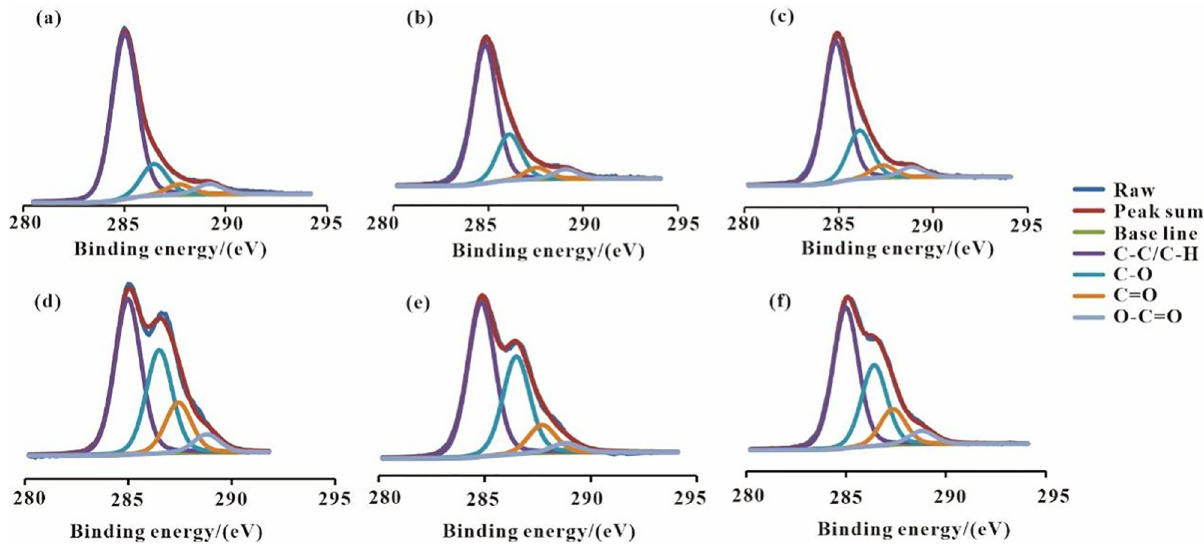
Fig 3. XPS fitting of different forms of organic carbon in M0 (a), M1 (b), M2 (c), G0 (d), G1 (e) and G2 (f).